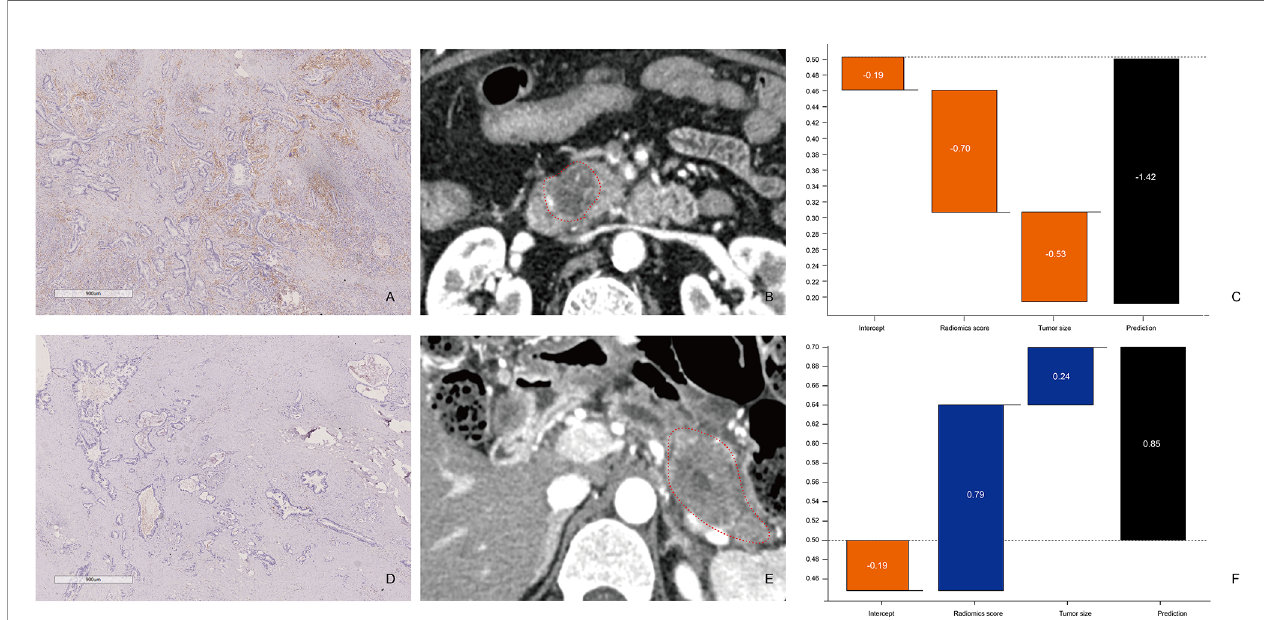
FIGURE 4 | Comparison between patients with low and high CD8 + T-cell in fi ltration (A – C) Patient 1: A 65-year-old man with PDAC in the CD8 + T-high group. (A) CD8 + T-cell in fi ltration is high (×20). (B) The axial portal-phase CT image shows an in fi ltrative, low-attenuation mass (arrows) located at the pancreatic head. (C) The prediction probability of low CD8 + T in fi ltration was 80.58% by XGBoost classi fi er. (D – F) Patient 2: A case of a 49-year-old man with PDAC in the CD8 + T-low group. (D) CD8 + T-cell in fi ltration is low (×20). (E) The axial portal-phase CT image shows an in fi ltrative, low-attenuation mass (arrows) located at the pancreatic body and tail. (F) The prediction probability of low CD8 + T-cell in fi ltration is 70.07% by XGBoost classi fi er.